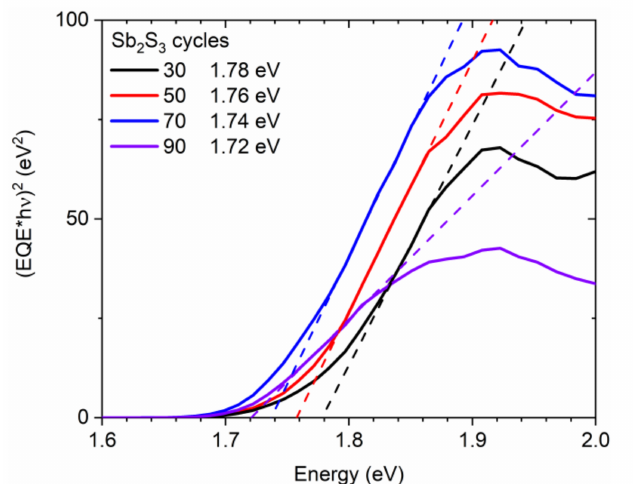
Figure 5. (EQE × h ν ) 2 vs. photon energy (solid line) of ZnO/TiO 2 core–shell NW heterostructures covered with a Sb 2 S 3 shell grown by CSP, using 30, 50, 70, and 90 cycles. The fitting dashed lines reveal the optical bandgap energy as the intercept of the linear part with the photon energy axis.